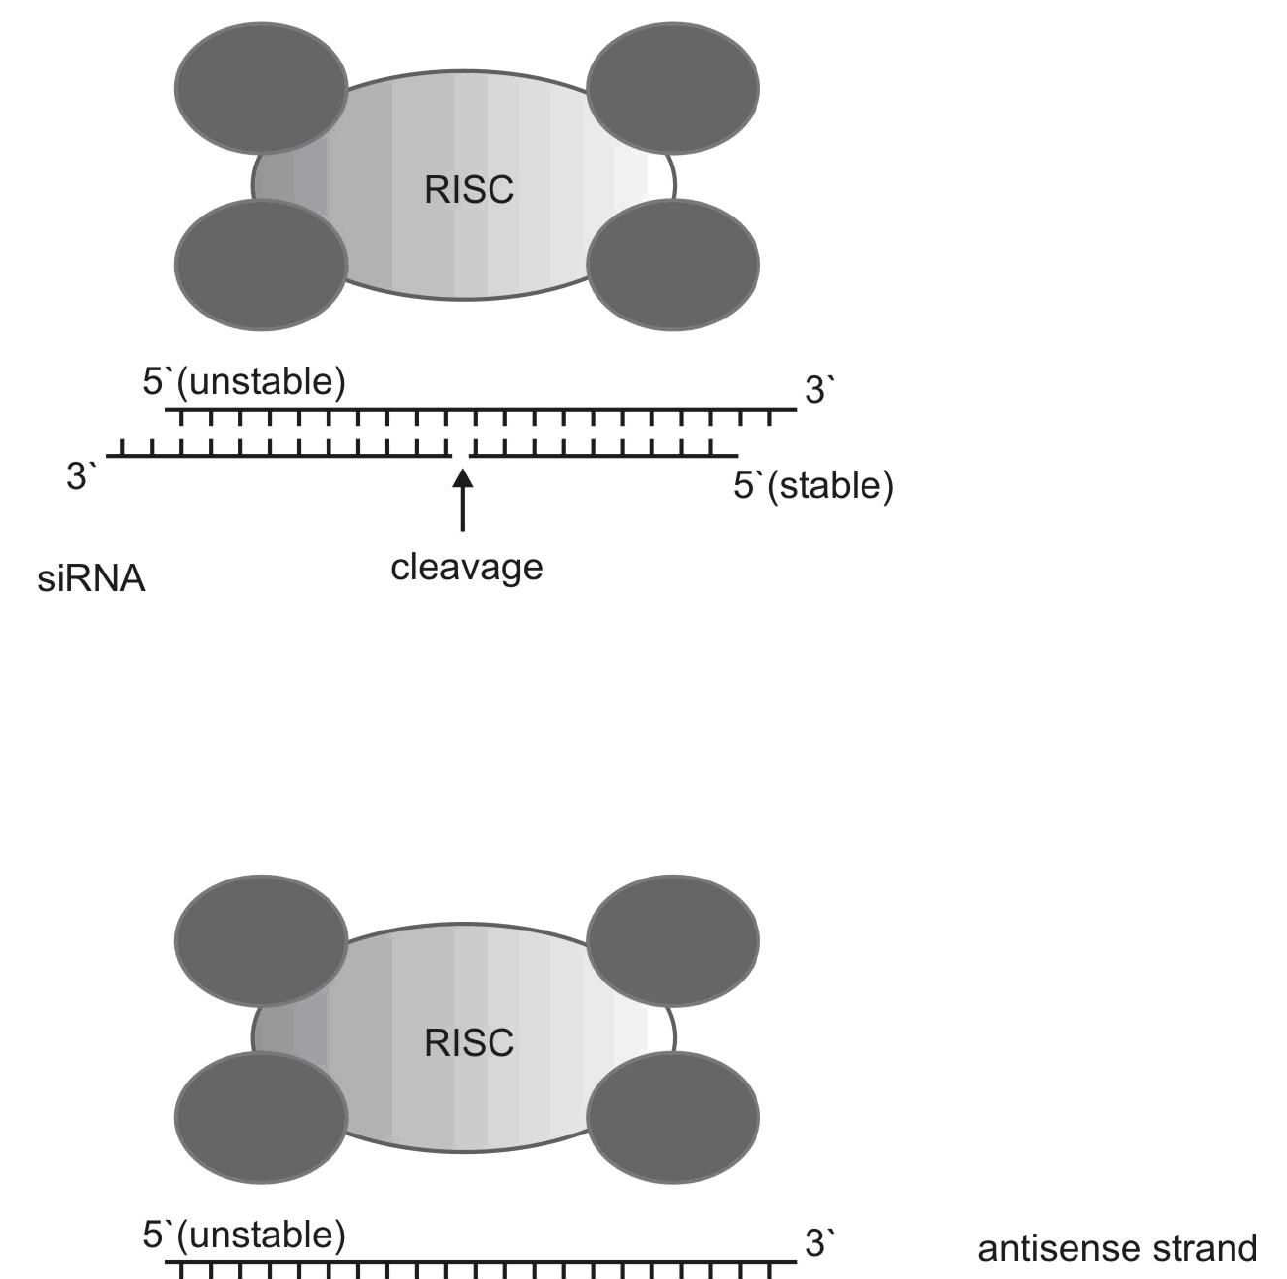
Figure S1. Role of thermodynamic stability features of small interfering RNAs (siRNAs) termini in RNA-induced silencing complex (RISC) activity. The more stable 5´ strand is cleaved while the more unstable 5´ strand is kept within the RISC for target RNA cleavage. Strand Analysis displays RNAi targets for which the antisense strands remains in RISC, i.e. which have a positive Gibbs free energy ( ∆ G)